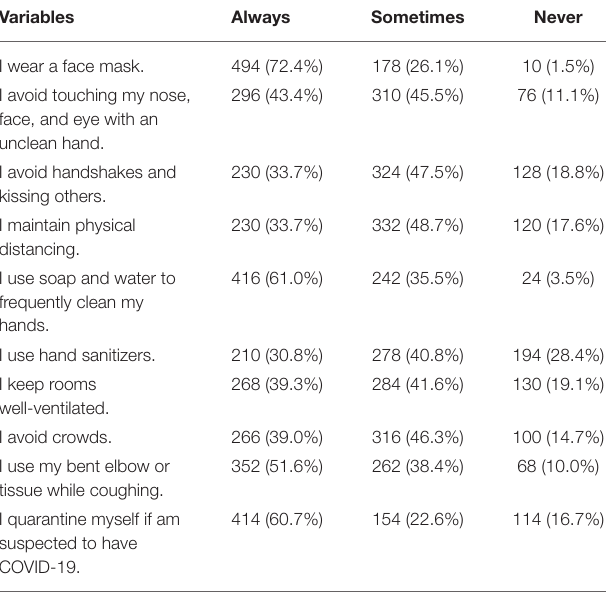
TABLE 3 | COVID-19 prevention behavior practices among university students,